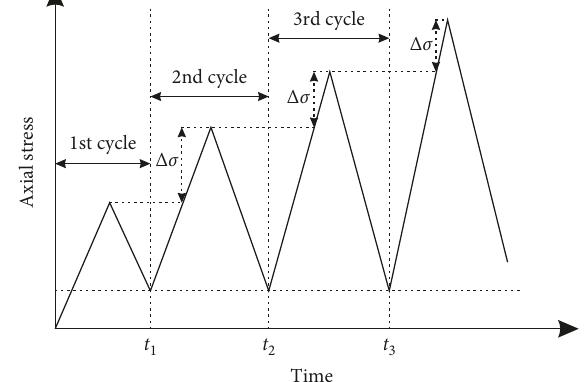
Figure 4: Loading way of the cyclic loading-unloading